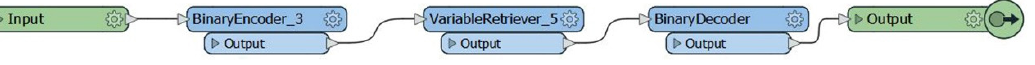
Figure 17. “GetGrandParentID” custom transformer workflow.